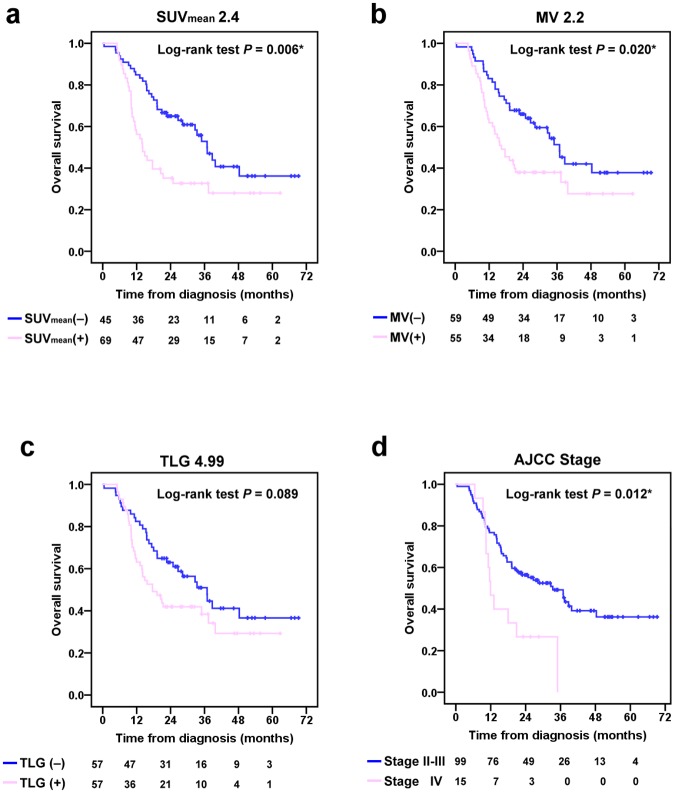
Kaplan-Meier plots of overall survival based on post-CRT FDG PET scans using (a) SUVmean2.4, (b) MV2.2, (c) TLG4.99 cut-offs, and (d) AJCC stage.